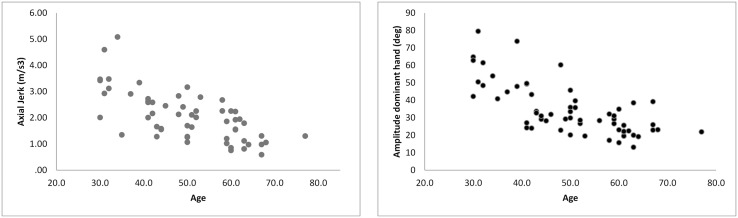
Scatter plots of the effects of age are presented for amplitude of the dominant hand (deg) and axial jerk (m/s3).